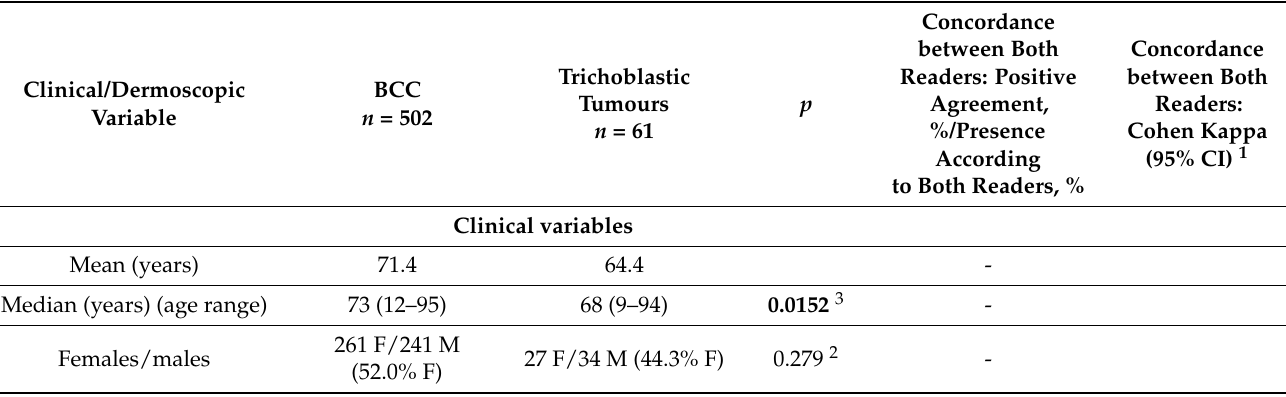
Table 1. Clinical and dermoscopic features in the studied groups—basal cell carcinoma vs. trichoblas- tic